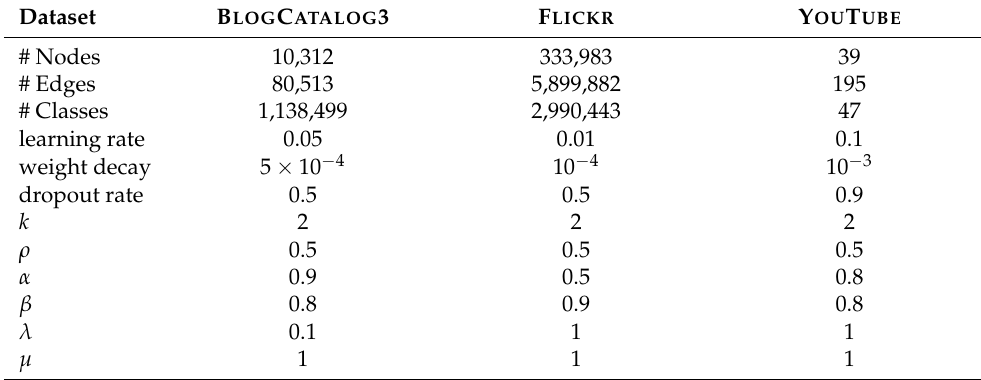
Table 1. Dataset